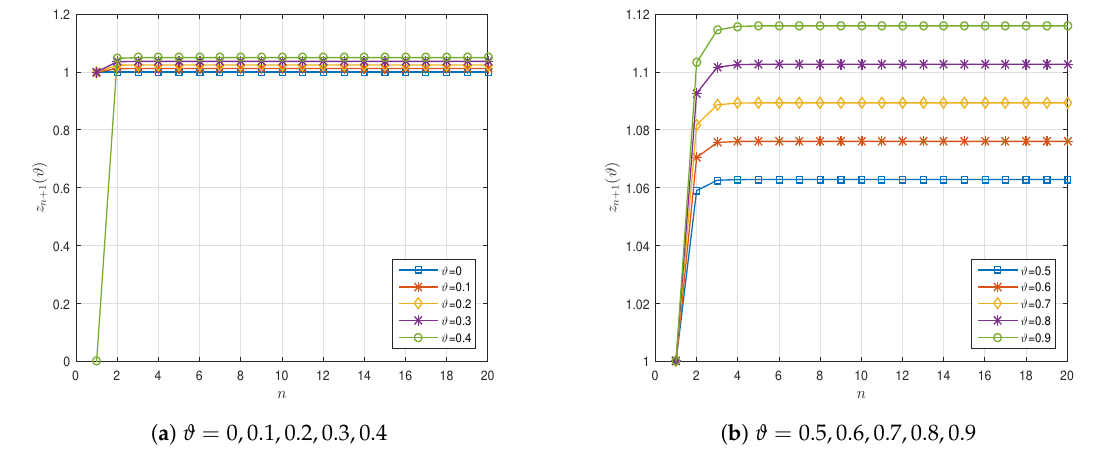
Figure 1. Graphical representation of z n + 1 ( ϑ ) in Example 1. Table 1. Numerical results of z n + 1 ( ϑ ) for n = 1,2, . . . ,20 and ϑ = 0, 0.1, 0.2, 0.3, 0.4 by using (21) in Example